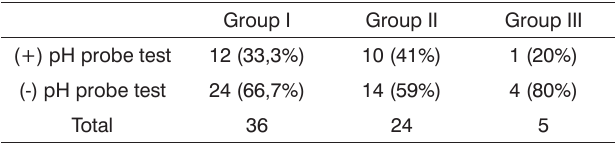
Table 1. Patient distribution according to the results from the pH probe study and age range.